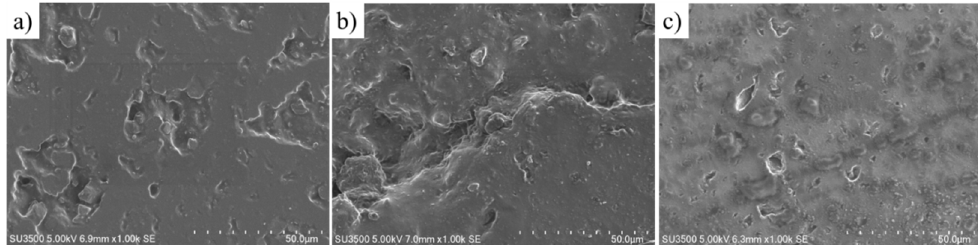
Figure 6. SEM micrographs with magnification 1000× of ( a ) PVC; ( b ) I.1; ( c ) II.4.